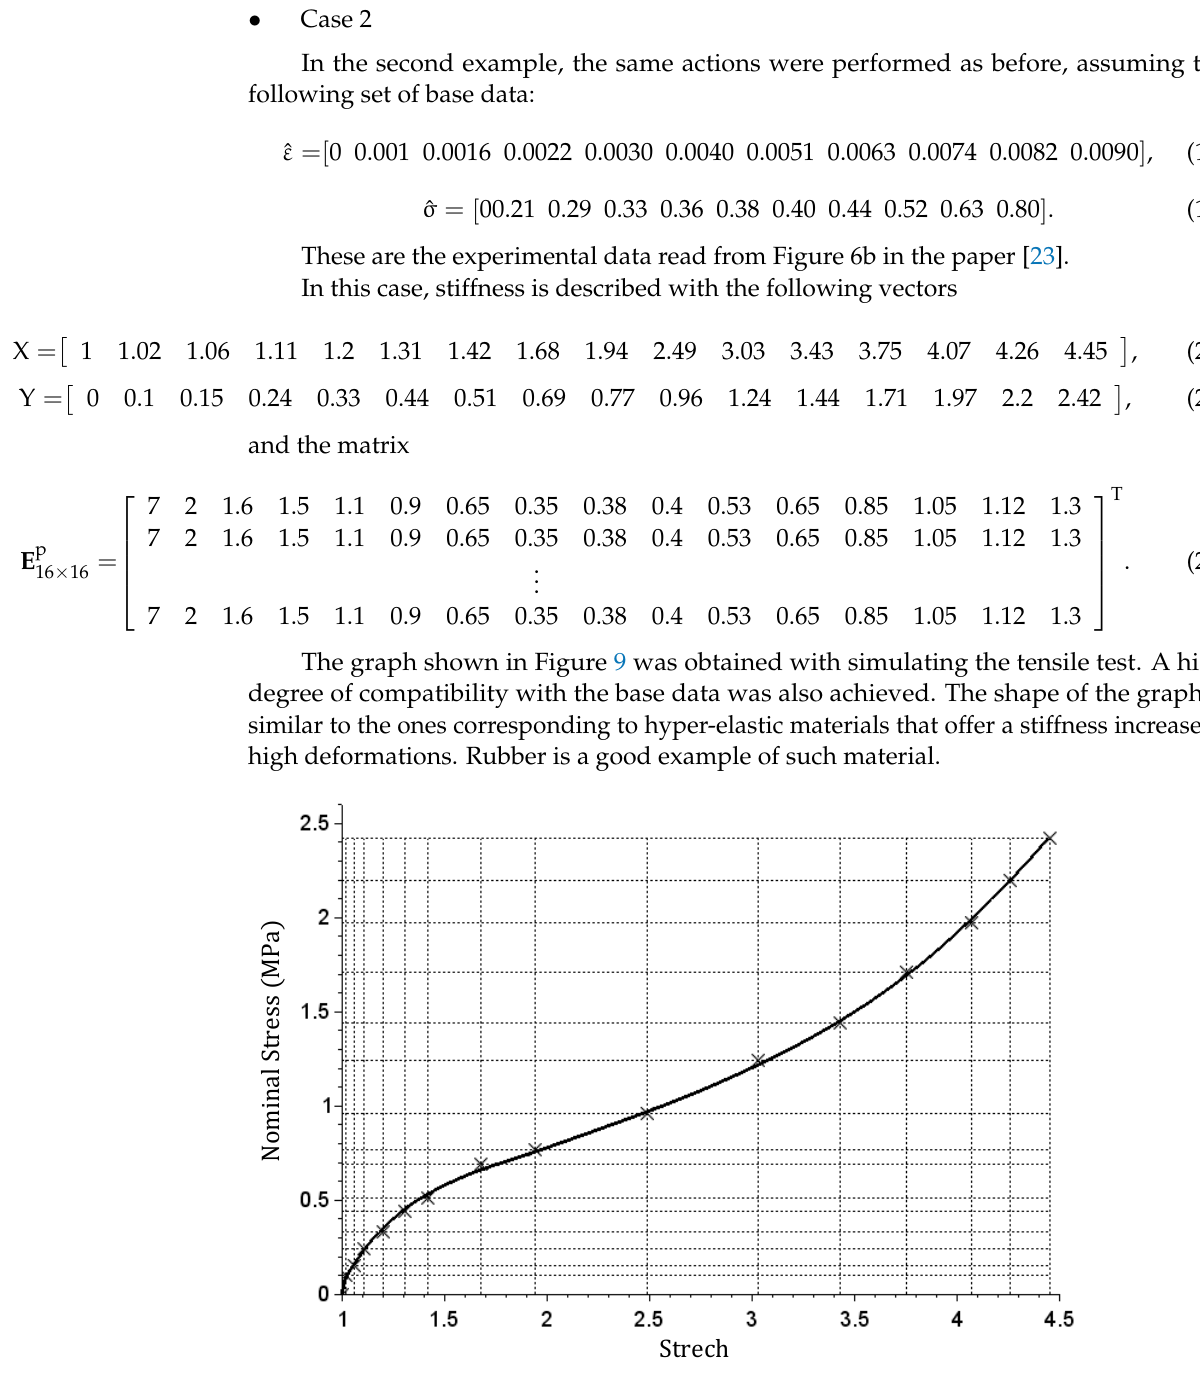
Figure 9. Relation graph achieved for the calibrated stiffness matrix in case 2 (the axis designations used in Figure 6b in Ref. [23] were used).